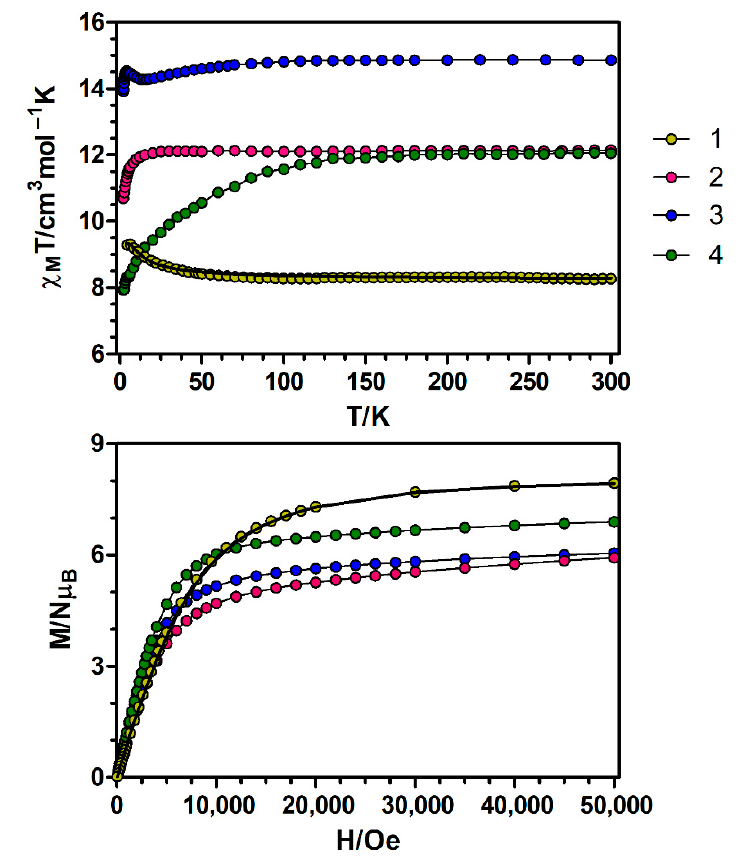
Figure 3. Top: Temperature dependence of the χ M T product at 1000 Oe for complexes 1–4 . Bottom: M versus H plots for complexes 1–4 at 2 K. The black solid lines show the best fits for complex 1 . The rest of the lines are a guide to the eye.